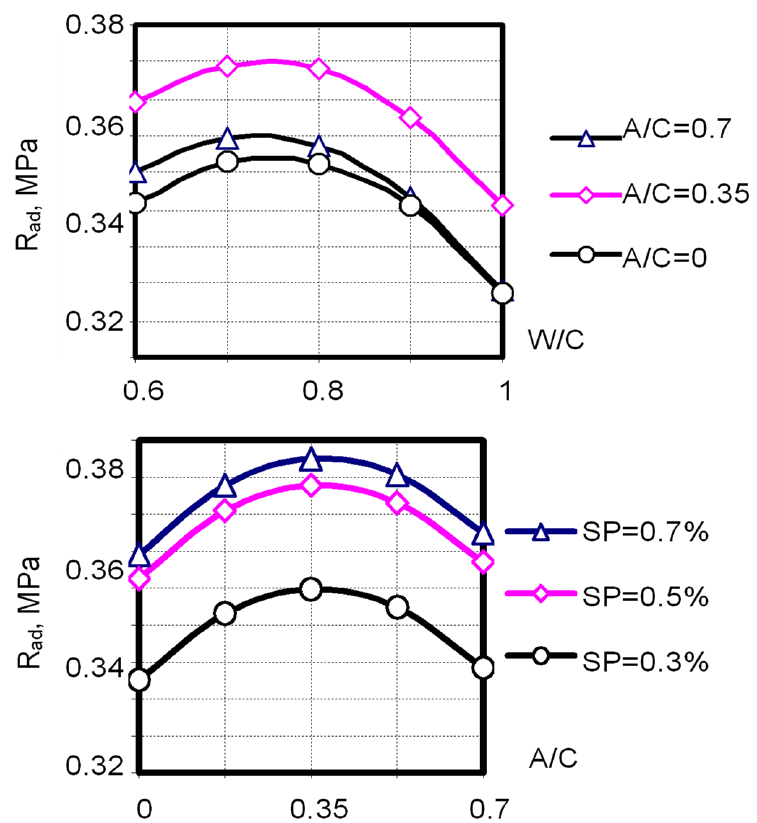
Figure 1. Dependence of the adhesive strength (MPa) of PFM 1 -modified cement–ash mortars on water–cement and ash–cement ratios at 7 days.